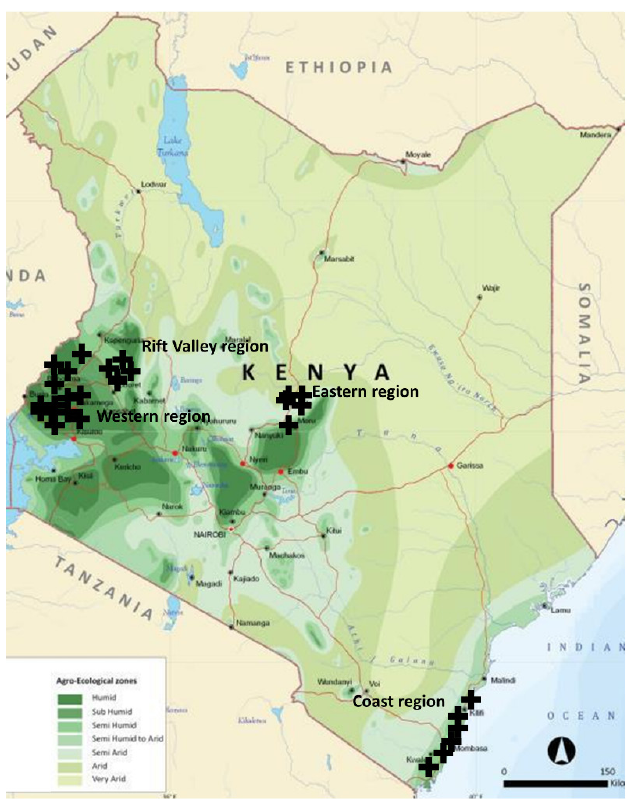
Fig. 1: Sample collection locations for guava accessions (crosses) from four regions of Kenya with Coast = 36, Eastern = 12, Rift Valley = 19, and Western =